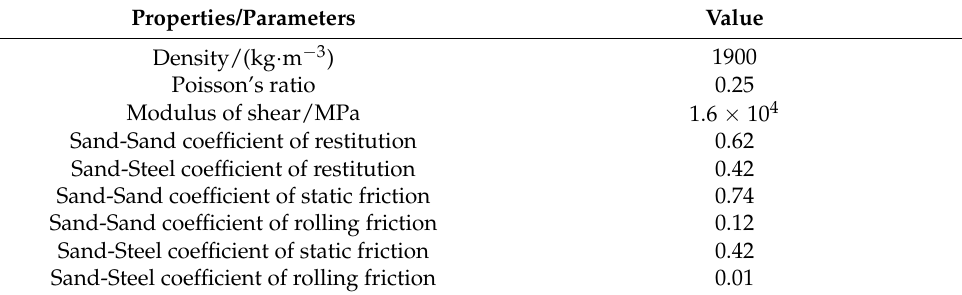
Table 1. Material properties and